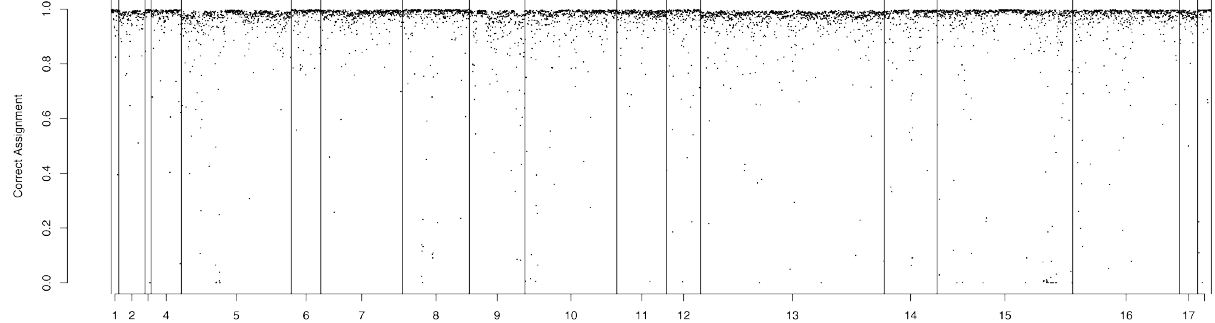
Figure 2. Assignment of individuals to their breeds using the USEPOPINFO model in structure . Each individual is represented by a dot of its posterior probability of correct assignment. Low values indicate migrants or